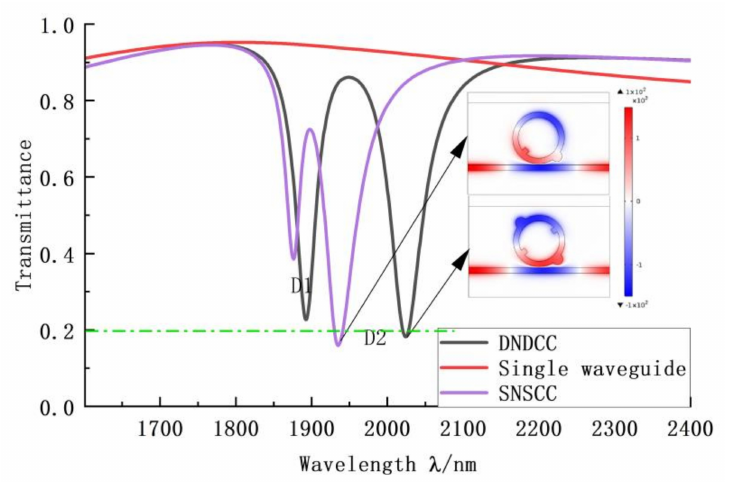
Figure 2. Transmission curve plots for DNDCC, SNSCC, and waveguide structures. Inset: Normal- ized magnetic field diagram for DNDCC and SNSCC